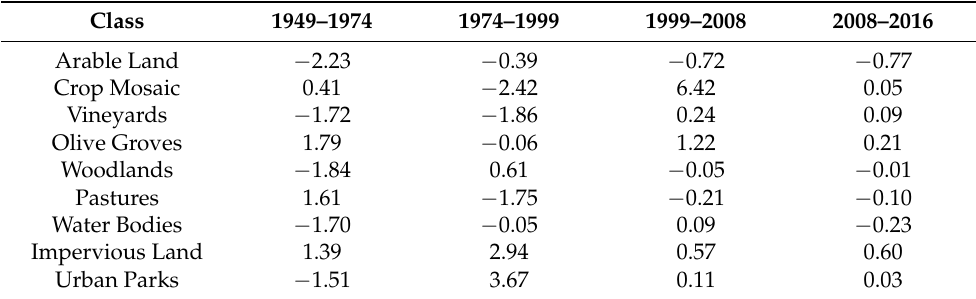
Table 2. Percent change over time (annual rate) in the per-capita surface area by land-use class in Rome,